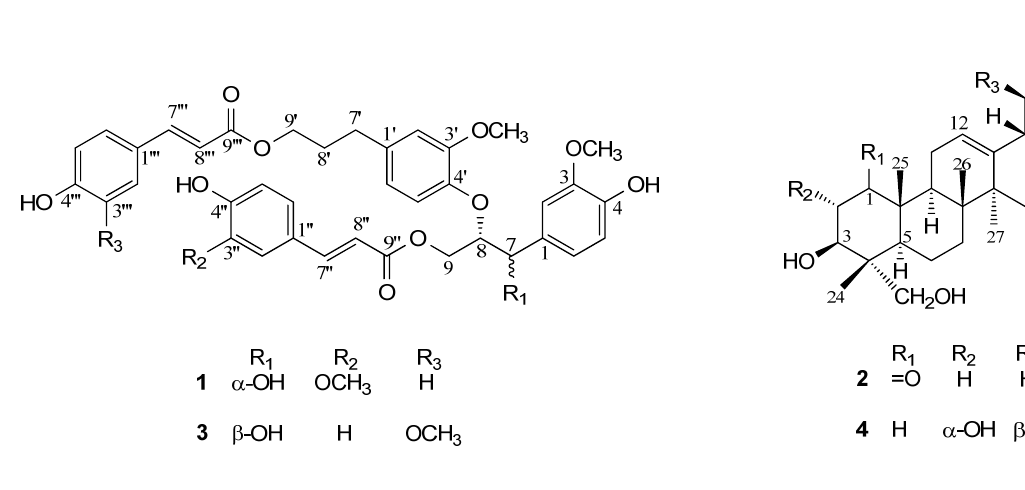
Figure 1. Chemical structure of compounds 1 – 18 from T. formosana